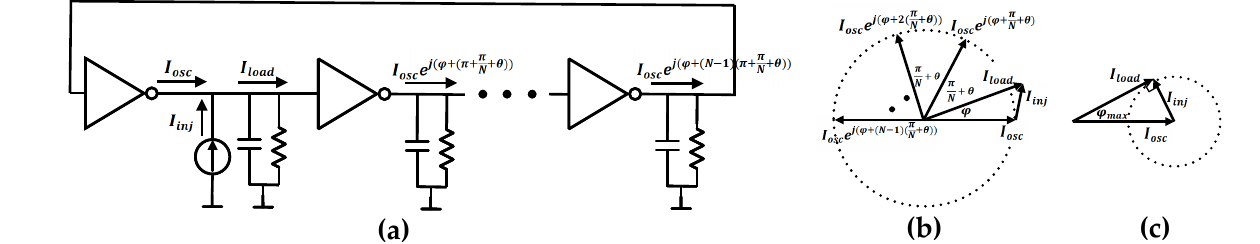
Figure 3. ( a ) N-stage single-end ring oscillator under injection locking; ( b ) Current vector diagram under injection locking; ( c ) Current vector diagram of the boundary of injection locking with given strength of the injection